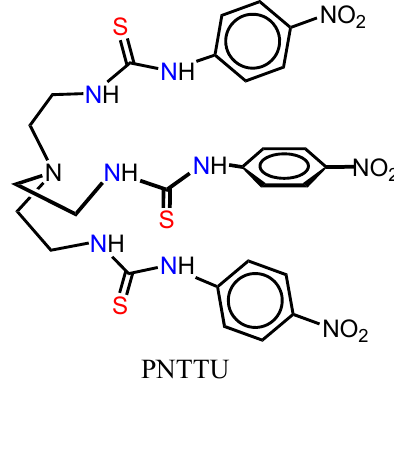
Figure 1. Chemical structure of PNTTU ( para- nitro tripodal